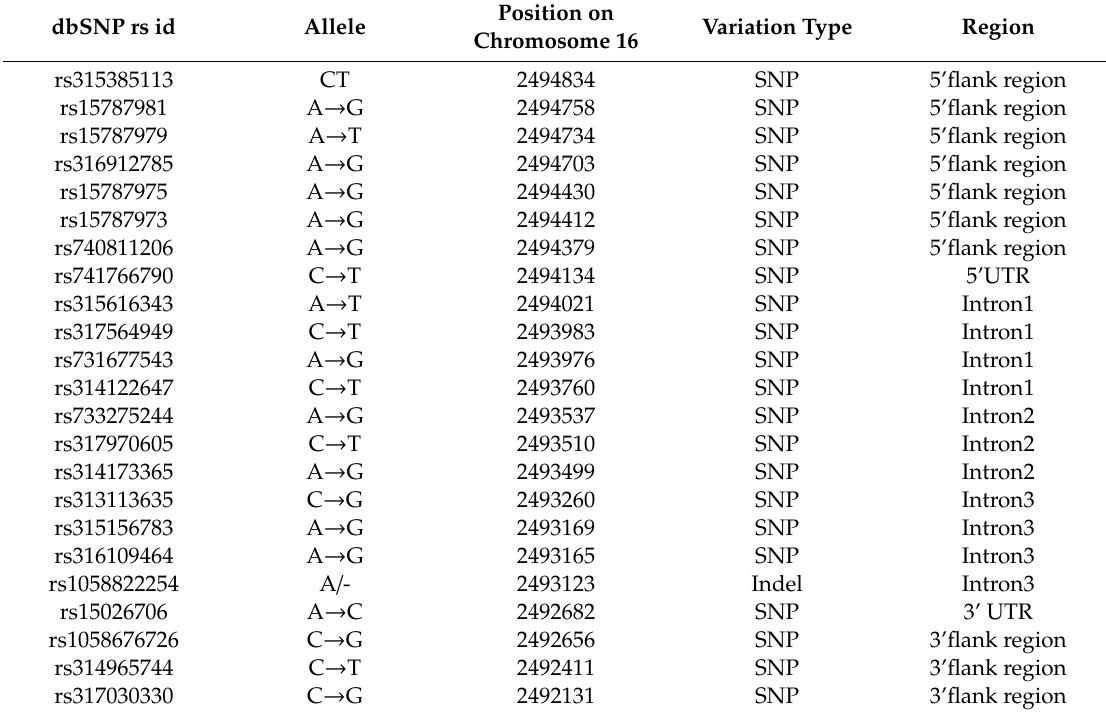
Table 3. Mutations detected in HEP21 gene from Ningdu Yellow